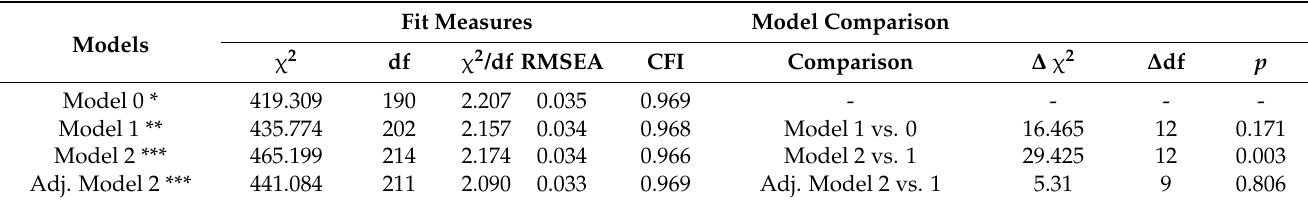
Table 4. Measurement invariance of IES-2 across gender.